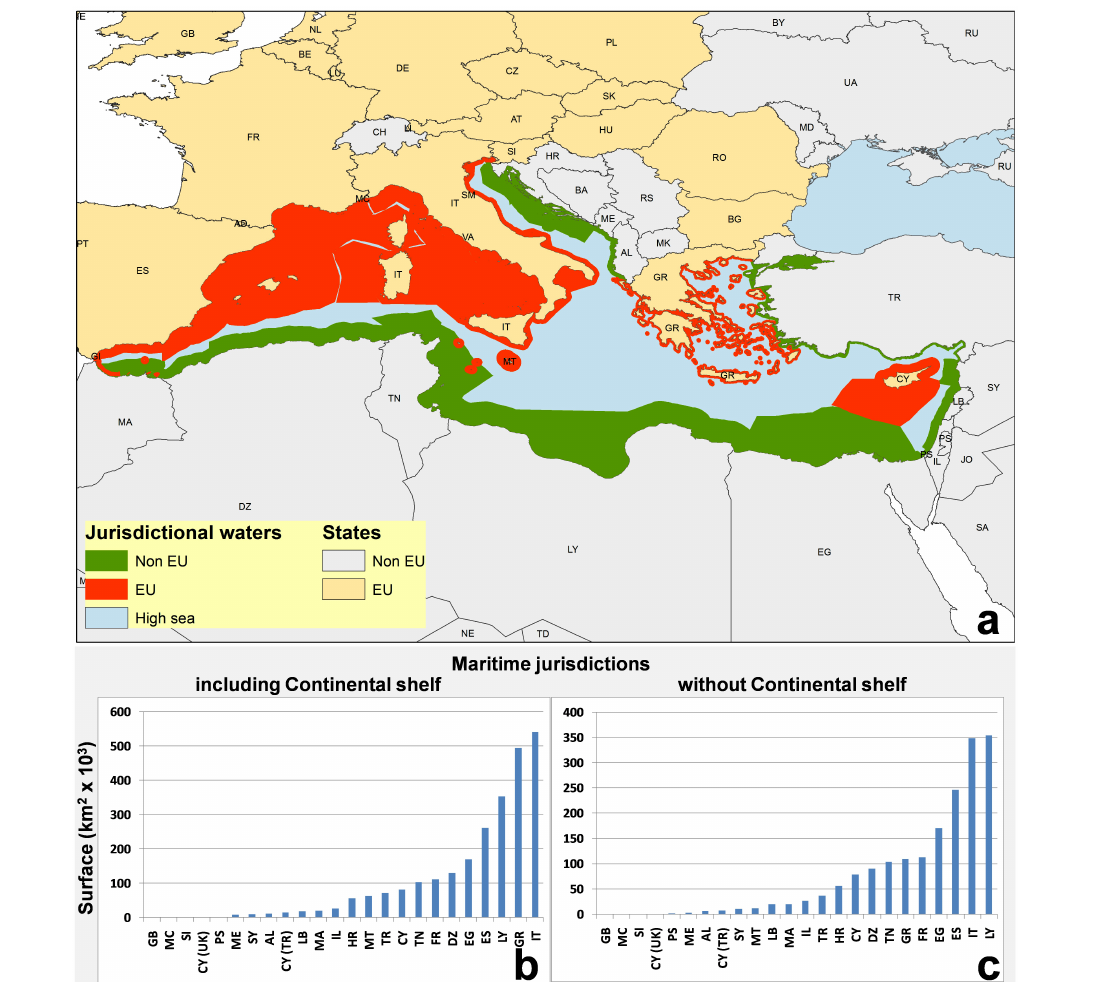
Fig. 2 . Map and bar charts of Mediterranean EU and non-EU countries (ISO 3166-2 Codes) jurisdictions (modified from Suárez de Vivero 2012). Further detailed maps can be found in Suárez de Vivero’s 2012 publication.